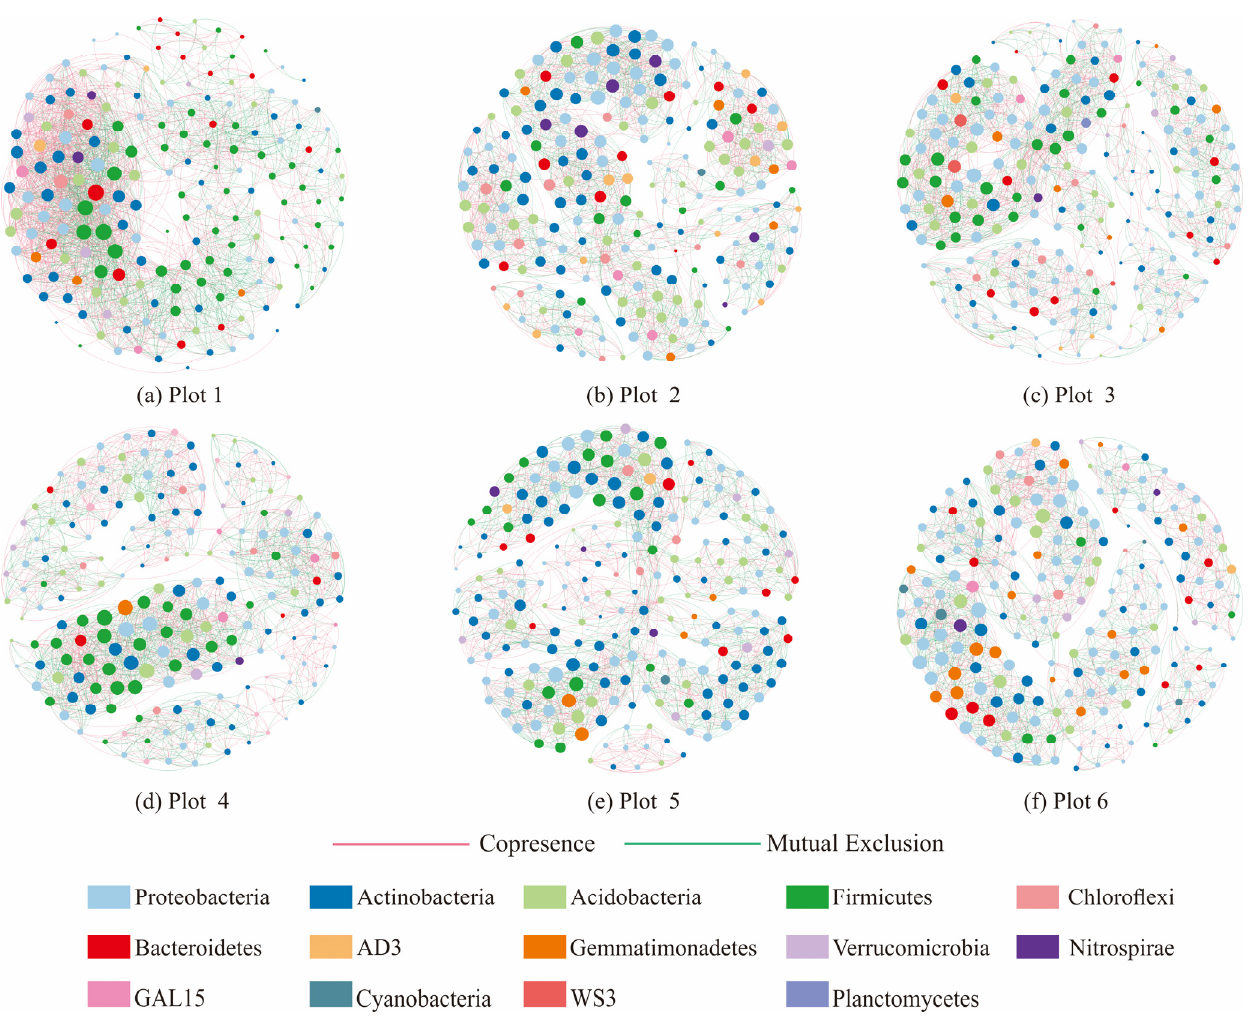
Figure 4. ( a – f ) Co-occurrence networks of bacteria at the ASV level in different plots. Table 4. Key topological characteristics of soil bacteria networks in different plots.